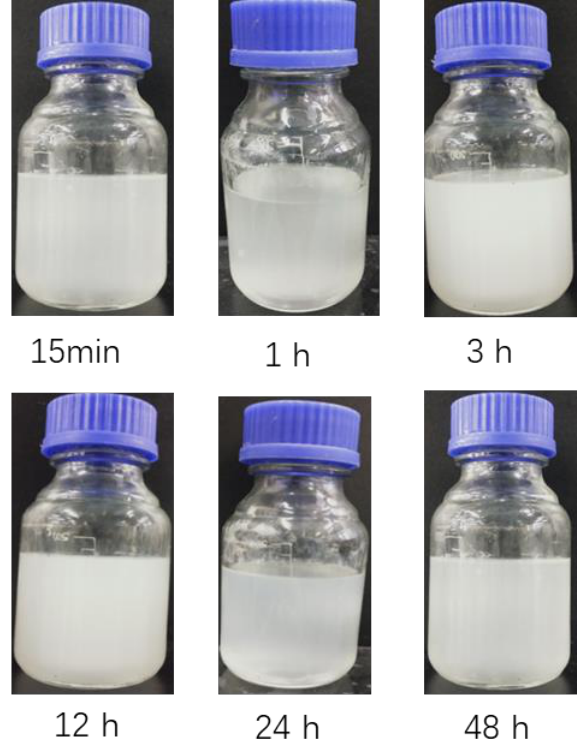
Figure 7. The compatibility of scale-inhibiting fracturing fluid system.